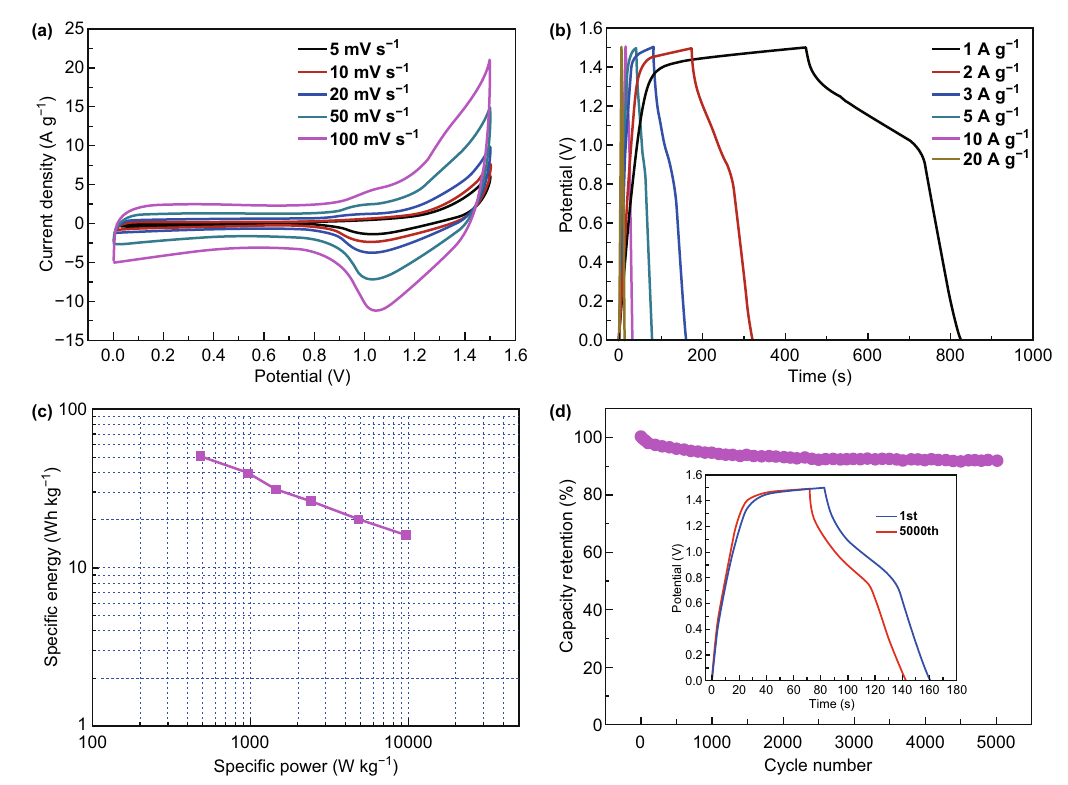
Fig. 8 a CV curves, b GCD curves, c Ragone plots and d cycling performance of the N,S‑CQDs/NiCo 2 S 4 //N‑rGO/Fe 2 O 3